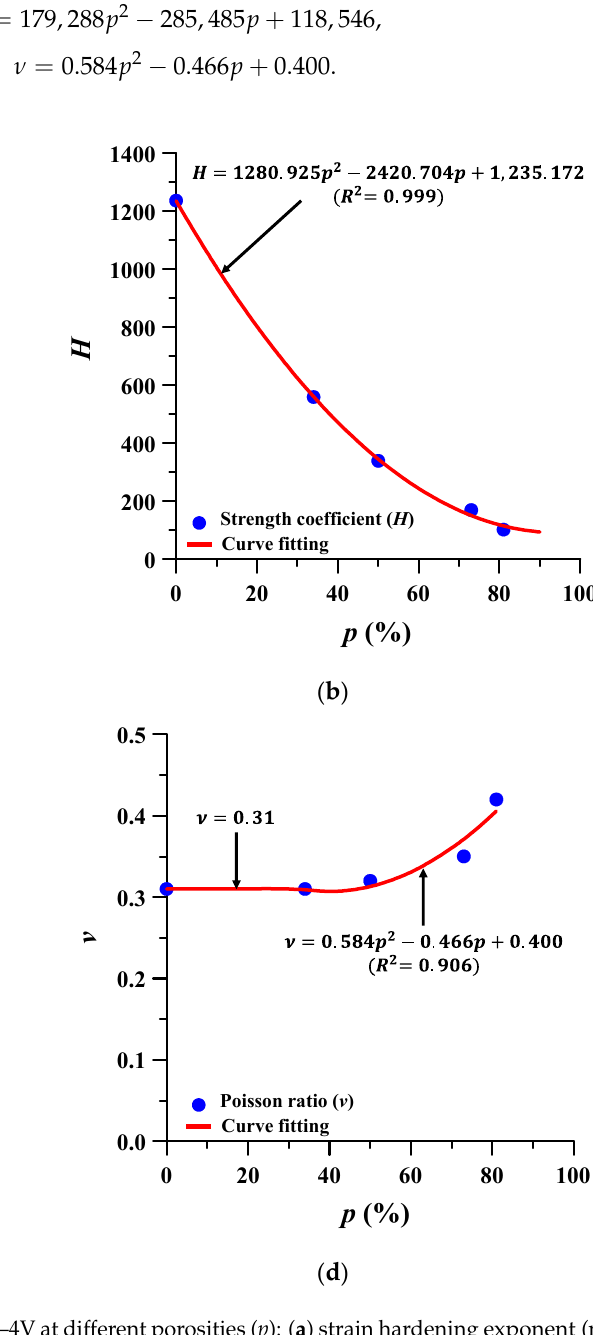
Figure 4. Estimation formula of material properties of Ti–6Al–4V at different porosities ( p ): ( a ) strain hardening exponent (n); ( b ) strength coefficient ( H ); ( c ) elastic modulus ( E ); and ( d ) Poisson’s ratio ( ν